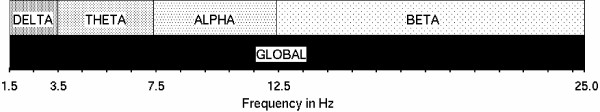
Power band definition.